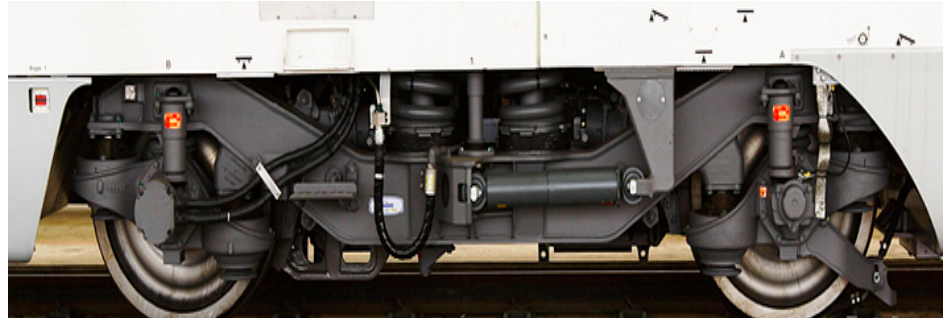
Figure 14. The motor bogie of the KTX.